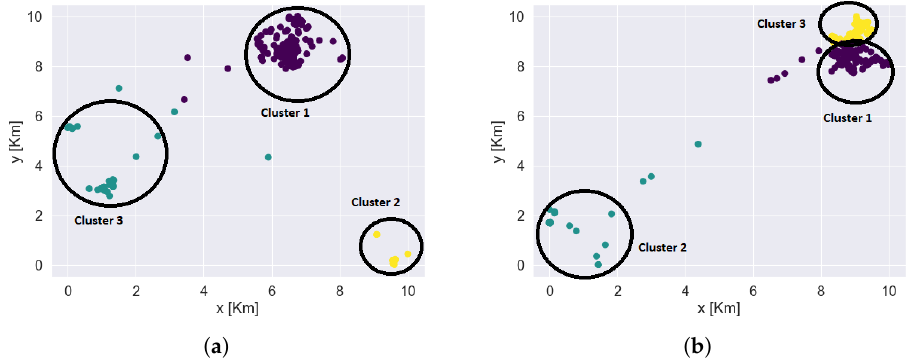
Figure 10. Clusters identified for Users. ( a ) User1; ( b ) User4.